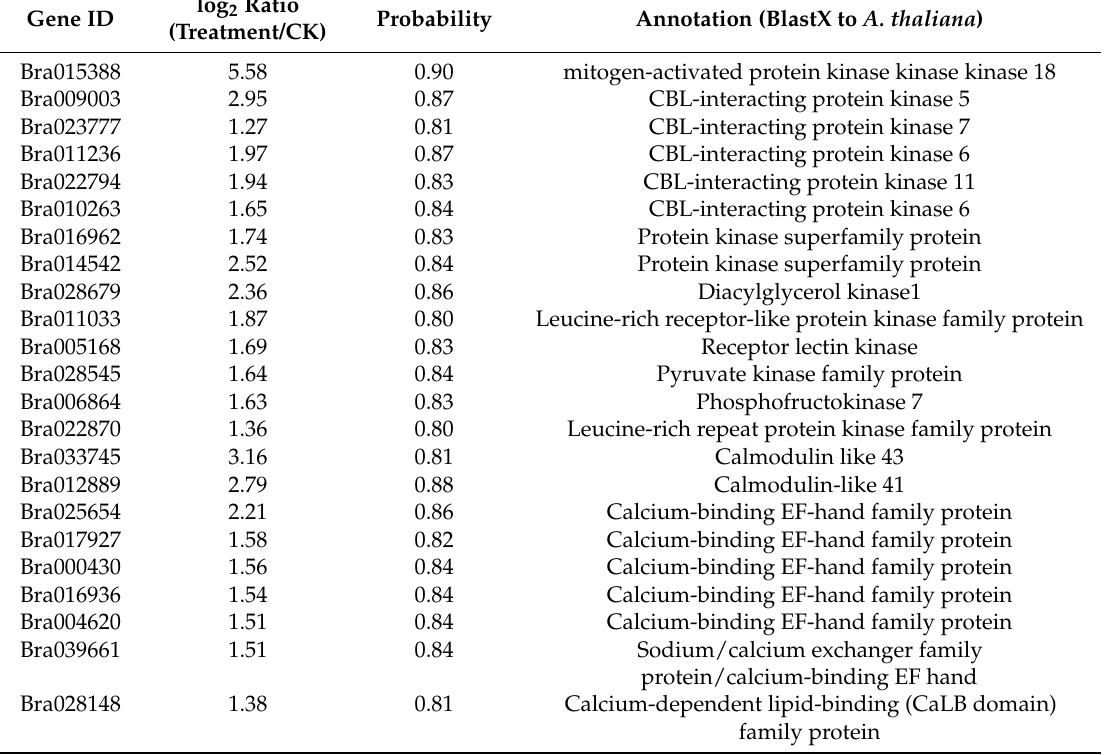
Table 2. The up-regulated differentially expressed genes (DEGs) that may be involved in signaling transduction in Chinese